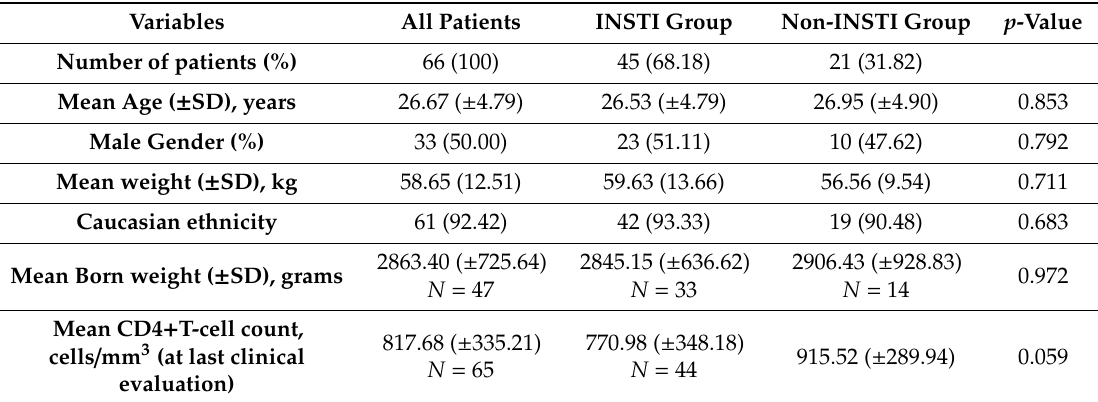
Table 1. Baseline demographic and clinical characteristics for the 66 patients analyzed.